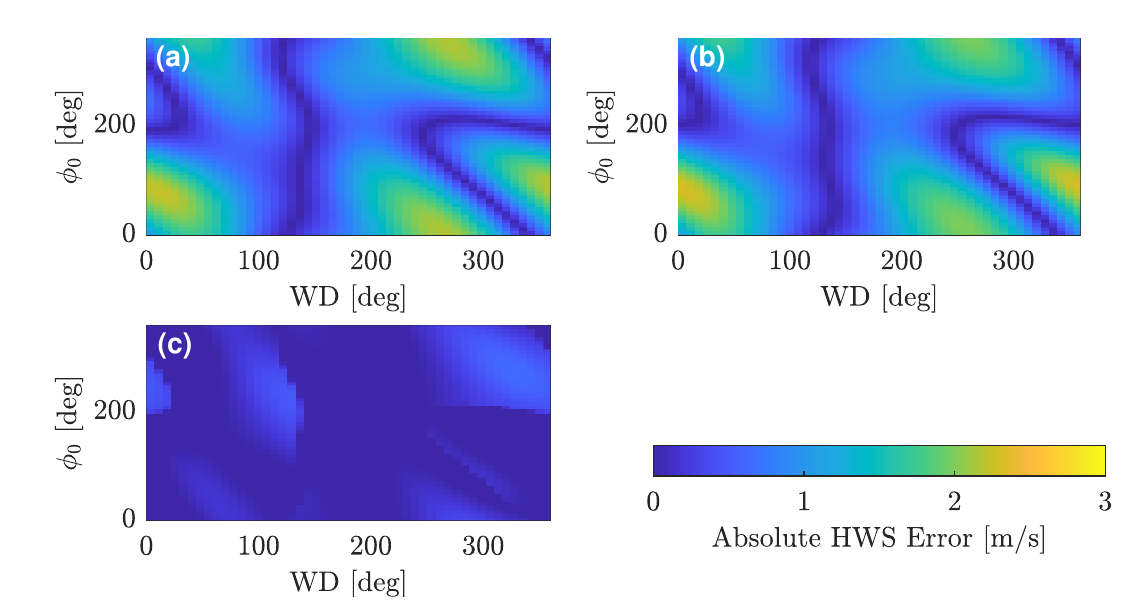
Figure 7. Validation of the analytical-error formulation in the 6 DoF scenario #3: HWS error (pa- rameters: A roll = A pitch = 10 deg, and A surge = A sway = A heave = 2 m/s). ( a ) The analytically estimated HWS error as a function of the wind direction (WD) and the initial scan phase ( φ 0 ). ( b ) The simulator-estimated HWS error. ( c ) The difference of ( a ) minus ( b ) (in absolute